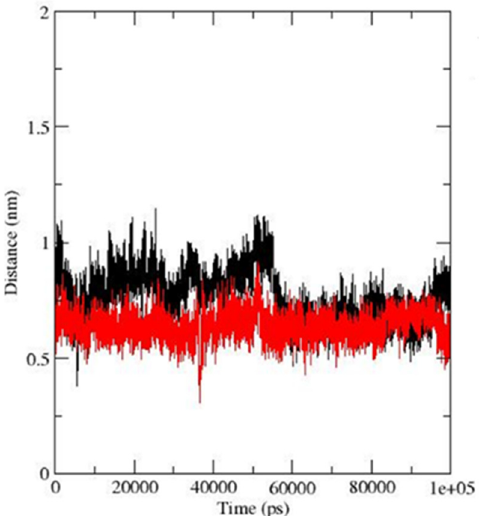
Figure 6. Minimum distance plot between the center of mass of (COM) CQ ligand and the center of masses of LYS76 of wildtype (black) and THR76 of mutant (red) PfCRT from MD production simulation trajectory. The average distance between the COMs of CQ ligand and THR76 residue is smaller than that between that of CQ and LYS76, as observed from MD production simulation.